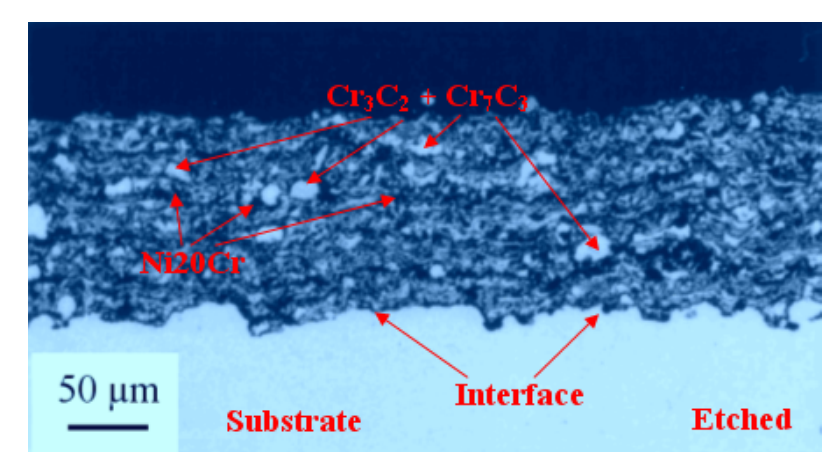
25(Ni20Cr) coating in the etched condition.